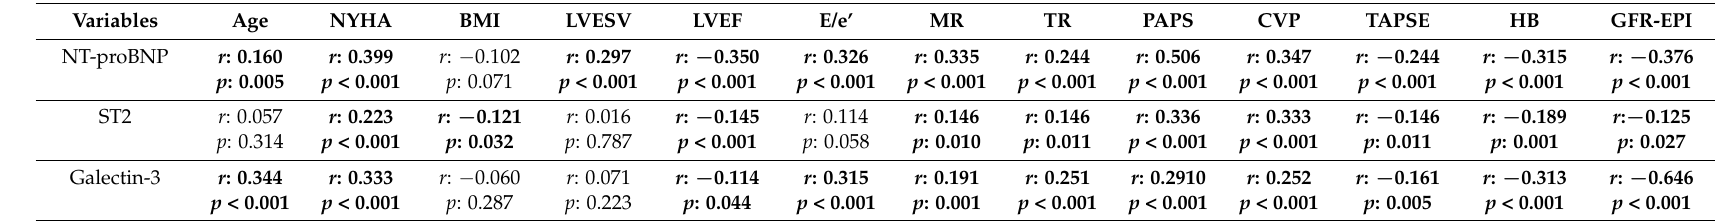
Table 2. Clinical correlates of biomarkers.